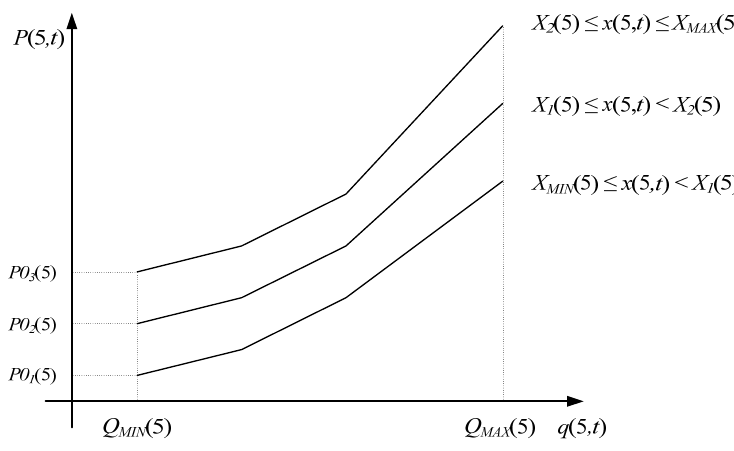
Figure 2. HPP 5 performance